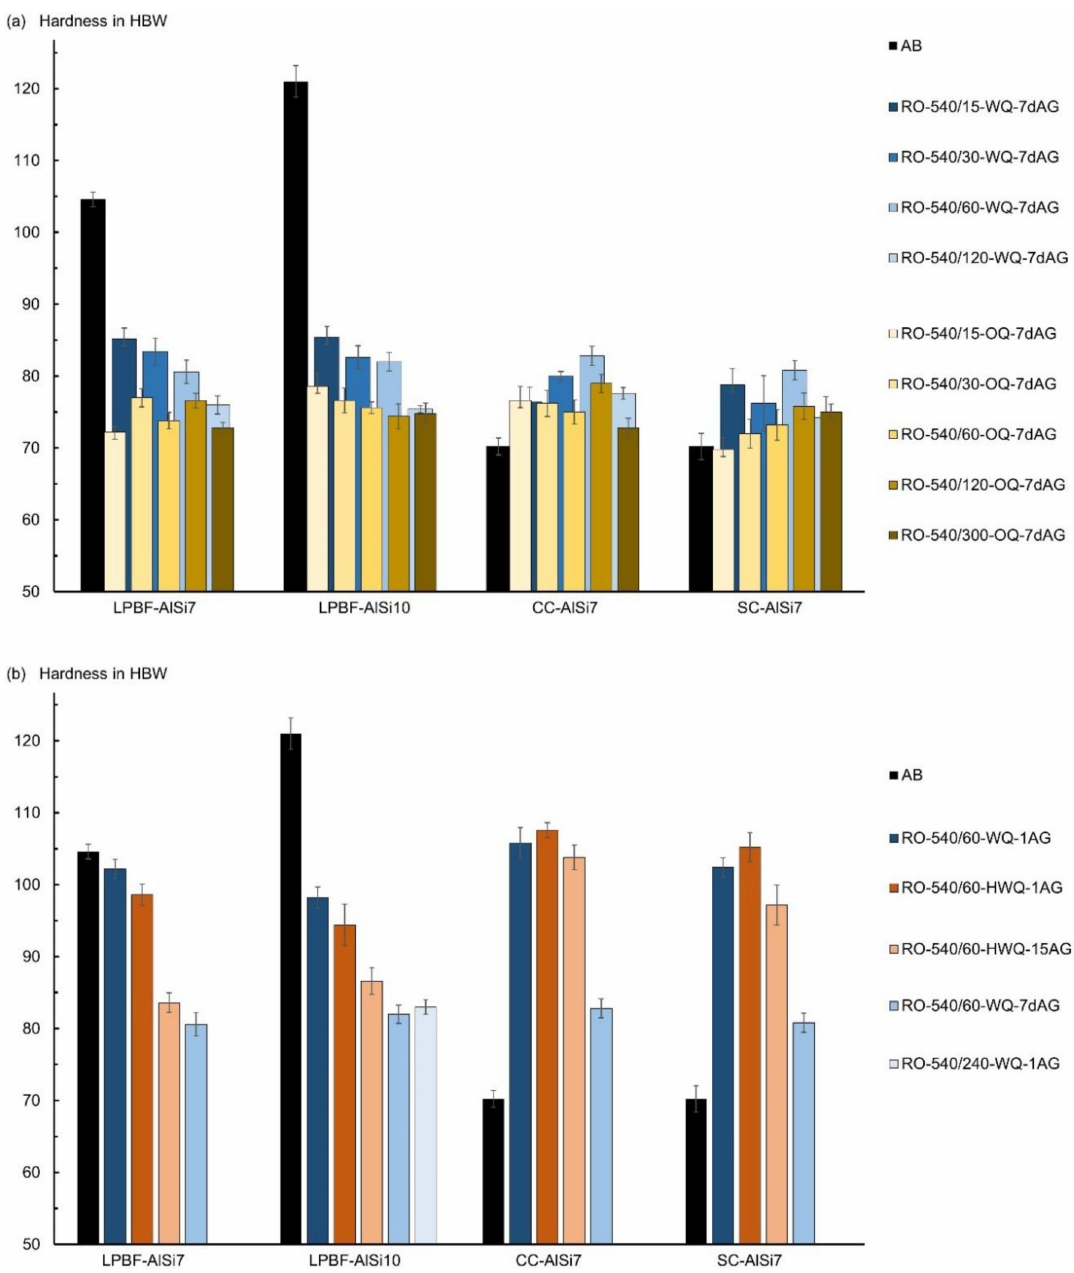
Figure 4. Hardness results for cast and laser powder-bed-fused samples in as-built (AB) and heat treated conditions; all results refer to heat treatments in the resistance furnace (RO) and were artificially aged (AG) for 150 min at 165 ◦ C. Oil quenched (OQ) and water quenched (WQ) results at varying solution annealing times are depicted in ( a ); hot water quenched (HWQ) results and varying dwell times at room temperature are shown in ( b ). The utilized nomenclature is explained in detail in Table